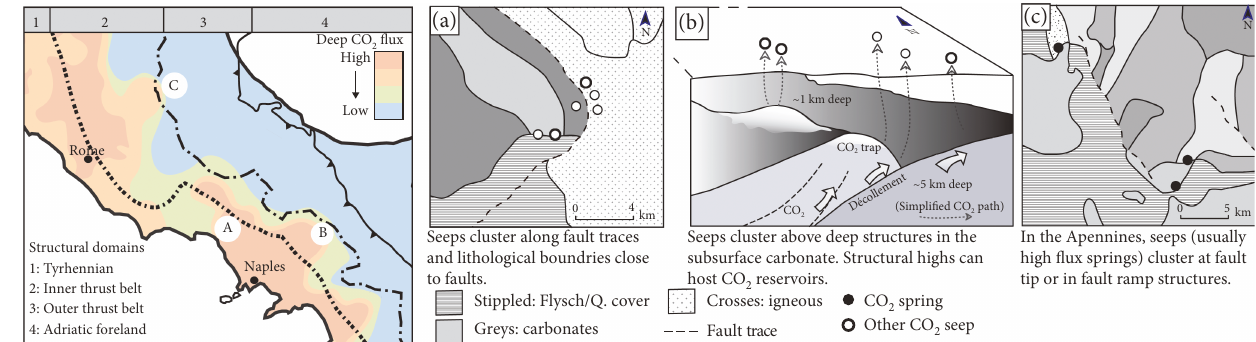
fl ux [18], and the location 2